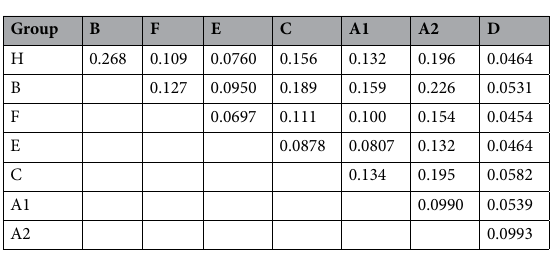
Table 3. Fst values for each pair of groups for A1, A2, B, C, D, E, F, H.